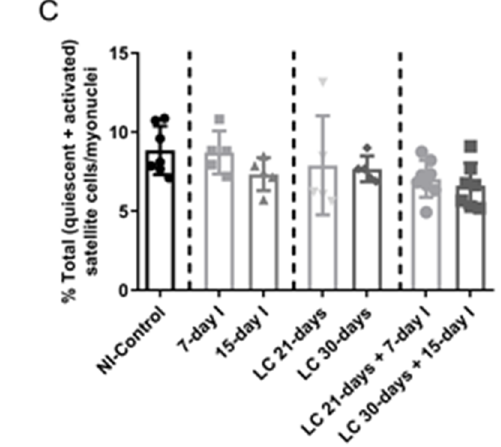
Figure 7. ( A ) Mean values and standard deviation of the percentage of activated satellite cell counts as identified by the number of Pax-7/Myf-5-positive cells in the gastrocnemius muscle of the different study groups of mice. Statistical significance is represented as follows: * p < 0.05 between 7-day I, 15-day I, LC 21-days, LC 30-days animals, and the NI-control mice; # p < 0.05 between any group of LC-cachexia mice and their respective group of mice bearing the two conditions (LC-cachexia and unloading); § p < 0.05 between any group of unloaded mice and their respective group of mice bearing the two conditions (LC-cachexia and unloading). ( B ) Mean values and standard deviation of the percentage of quiescent satellite cell counts as identified by the number of Pax7-positive cells (Myf-5-negative) in the gastrocnemius muscle of the different study groups of mice. Statistical significance is represented as follows: * p < 0.05 between 7-day I, 15-day I, LC 21-days, LC 30-days animals, and the NI-control mice. ( C ) Mean values and standard deviation of the percentage of total satellite cell counts as identified by the number of quiescent and activated satellite cells in the gastrocnemius muscle of the different study groups of mice. Statistical significance is represented as follows: * p < 0.05 between 7-day I, 15-day I, LC 21-days, LC 30-days animals, and the NI-control mice. Definition of abbreviations: Pax-7, paired box -7; Myf-5, myogenic factor 5; NI, non-immobilized; I, immobilization; LC, lung cancer.